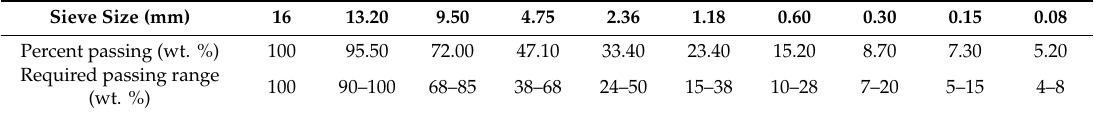
Table 2. Aggregate Gradation for AC-13 Mixture Design.